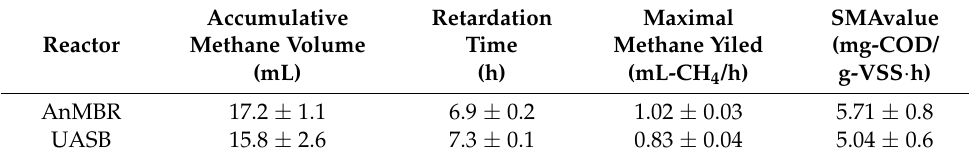
Table 1. Specific methanogenic activity of the sludge from AnMBR and UASB.